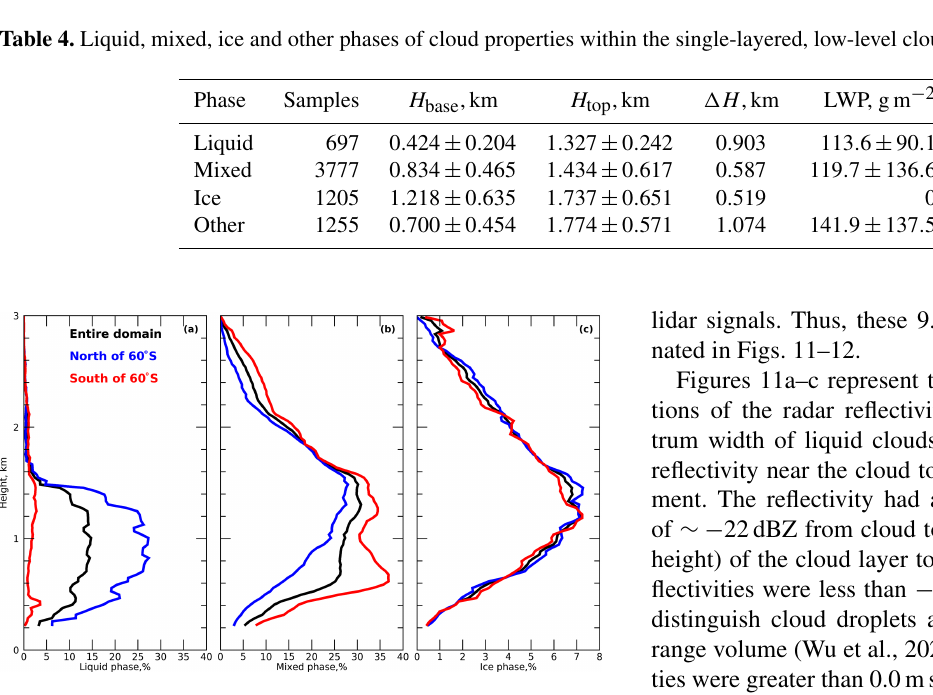
Figure 10. Occurrence frequencies of classified mixed-phase, liq- uid, and ice clouds over the entire domain (black), north of 60 ◦ S (blue), and south of 60 ◦ S (red) during